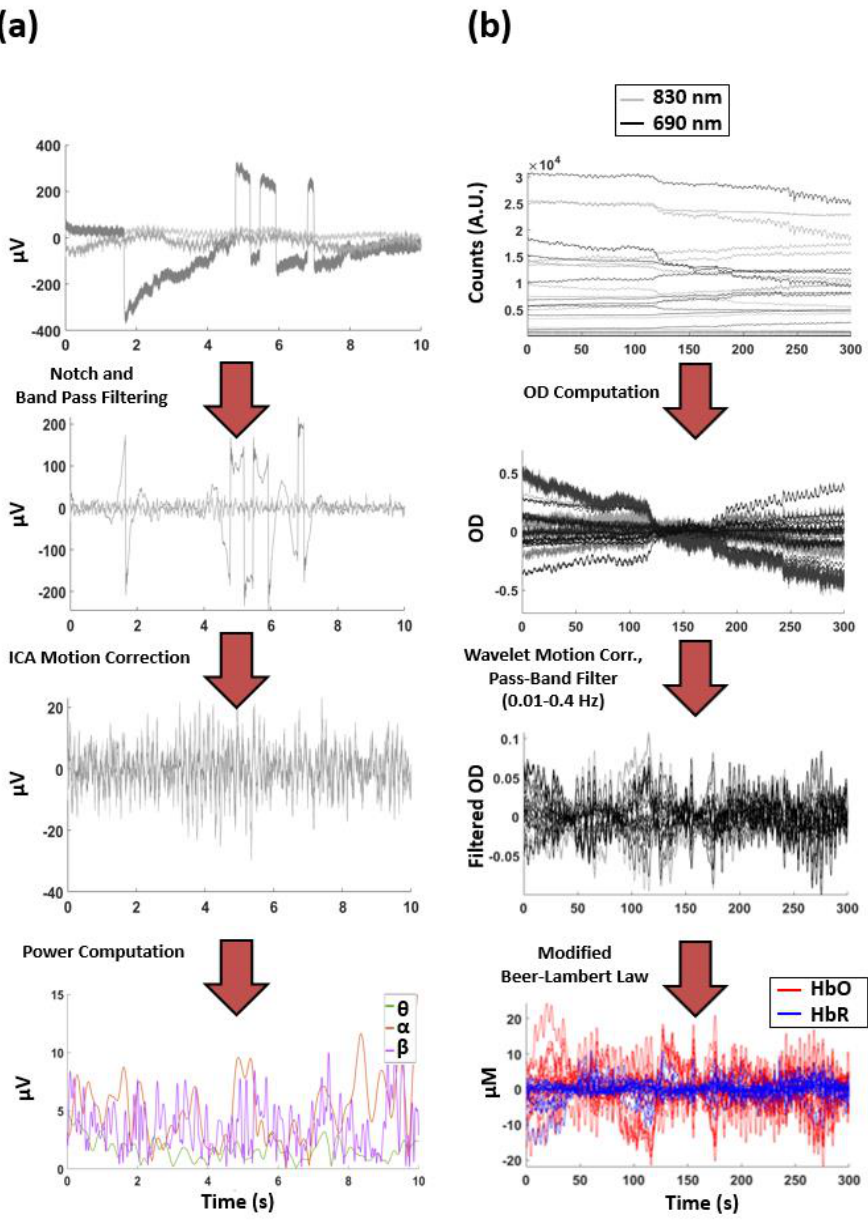
Figure 2. ( a ) Pre-processing of the EEG involving band-pass filtering, independent component analysis (ICA) motion correction and power envelope computation. The end results of the EEG pre-processing were artifact-corrected EEG power envelopes for the 128 channels in the three frequency bands of interest (theta, alpha and beta). ( b ) Pre-processing of the fNIRS involving Optical Densities (OD) computation, wavelet-based motion correction and oxy-hemoglobin (HbO) and deoxy-hemoglobin (HbR) computation. The end results of the fNIRS pre-processing were artifact-corrected HbO and HbR changes in both the long and the short separation channels.